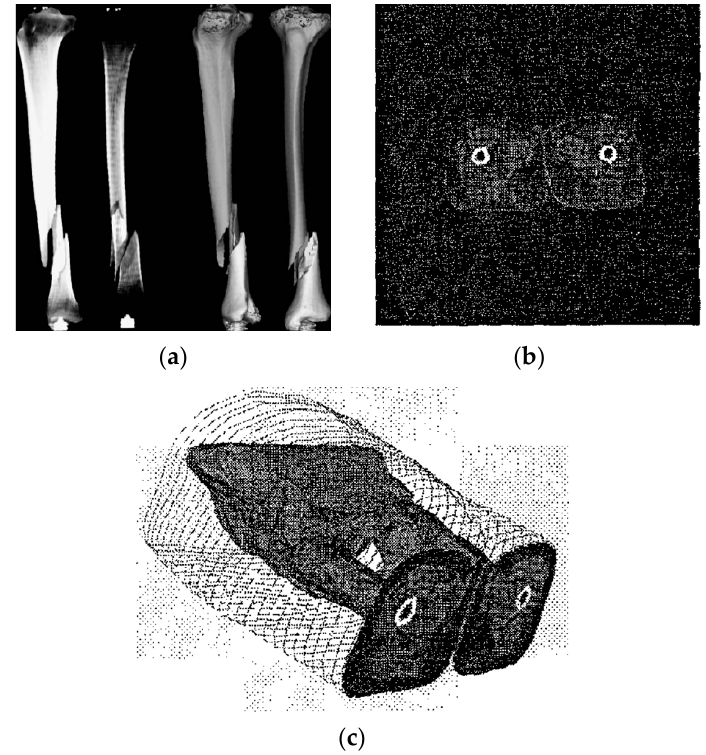
Figure 1. ( a ) Bone fracture displays in 3D visualization software, the Sobel-filter is used for detecting the outline of bone [11]; ( b ) CT image slides and ( c ) 3D visualization [4].